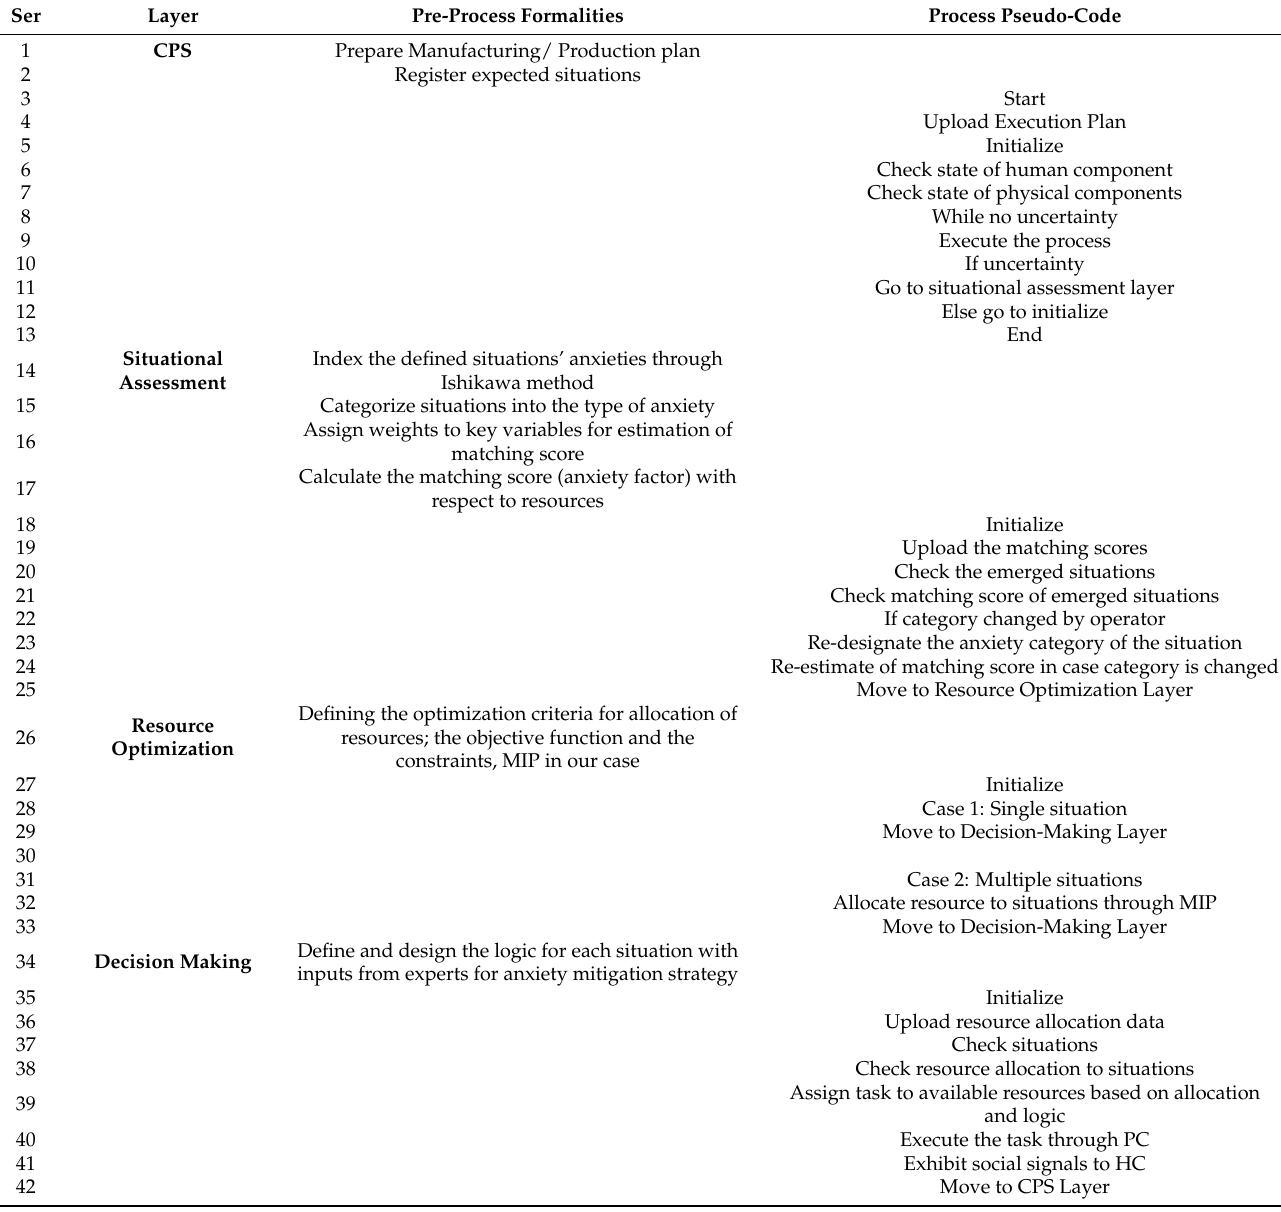
Table 2. Process for decision-making